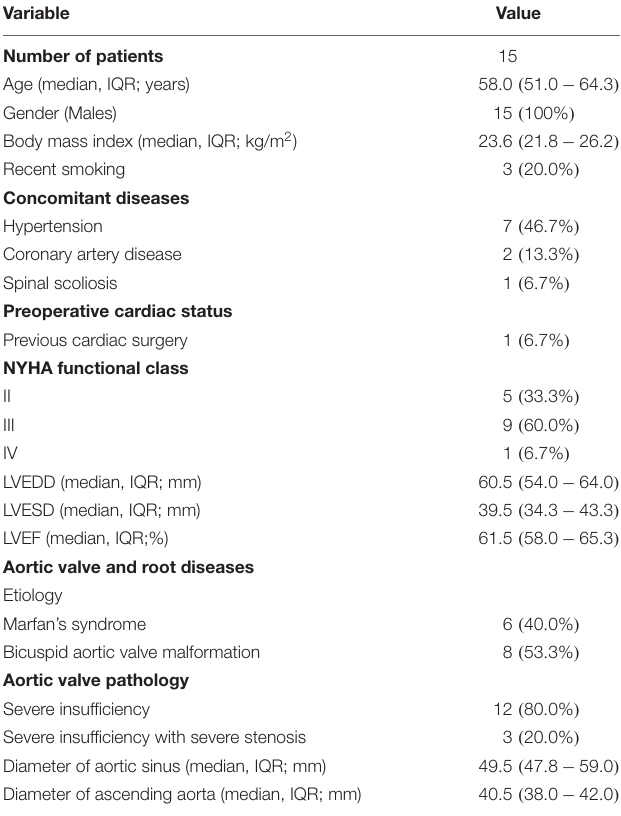
TABLE 1 | Baseline characteristics.